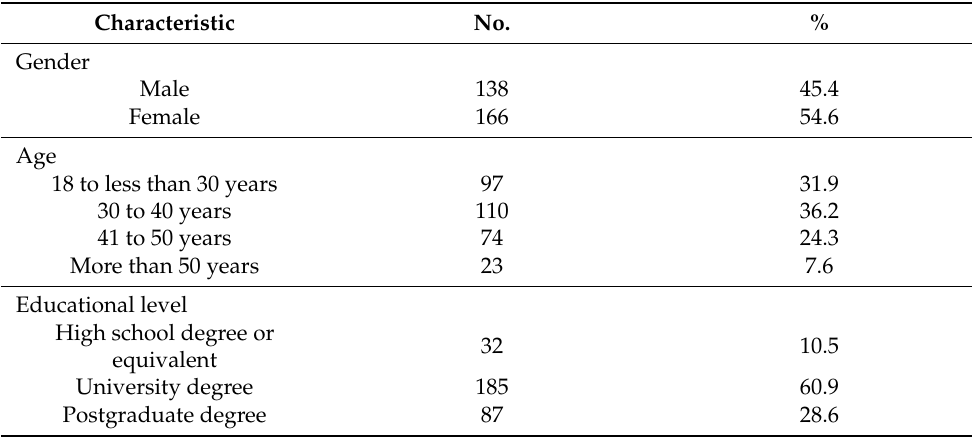
Table 1. Respondents’ demographic